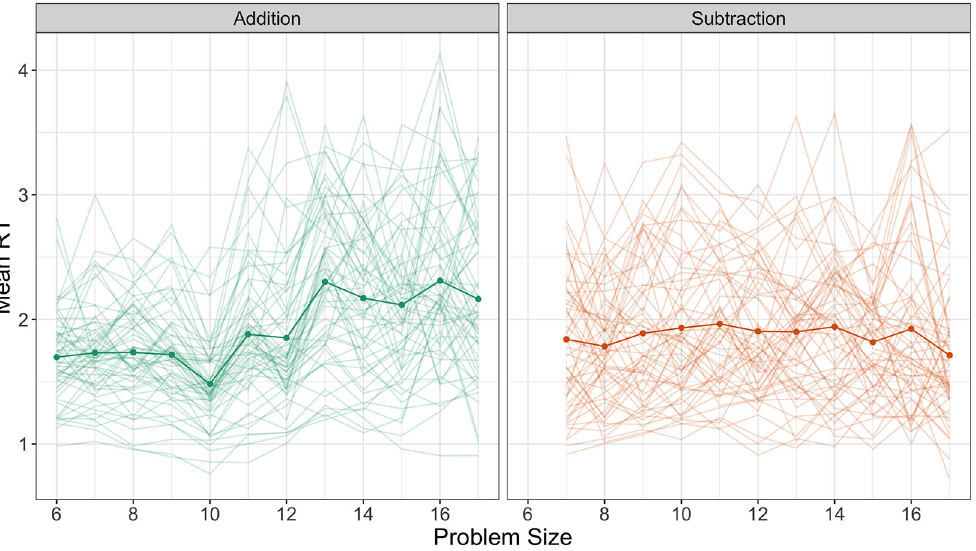
Note. Each line represents an individual participant’s mean RT ( y -axis) for each problem size ( x -axis) for each operation (panels) in the missing- operand task. The thicker line indicates the mean across all